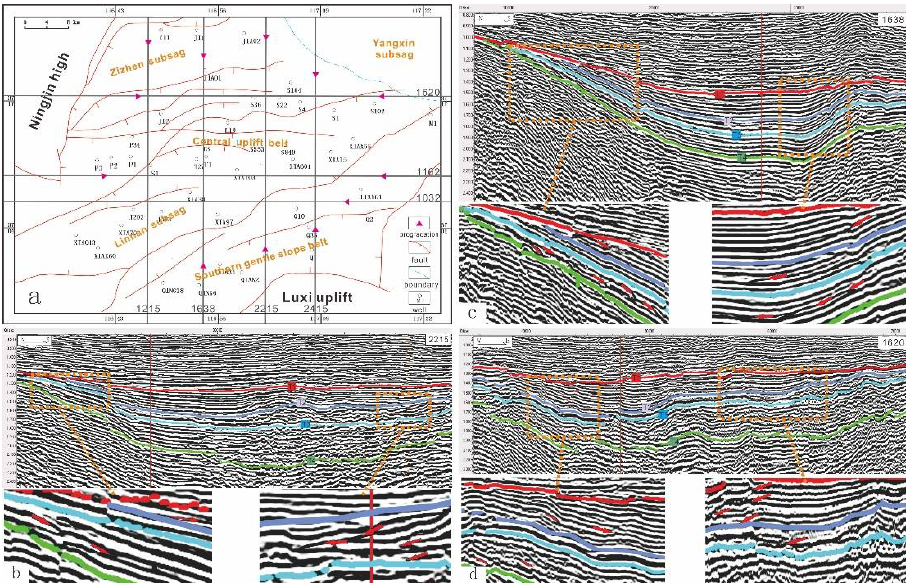
Figure 8. ( a ) Seismic survey lines in the Huimin depression and the planar position of the main progradation reflection points of each survey line. The diagrams show the ( b ) progradation reflection characteristics of the Es 2 to the Ed in north–south trending seismic section 2215, ( c ) progradation reflection characteristics of the Es 2 to the Ed in north–south trending seismic section 1638, and ( d ) the progradation reflection characteristics of the Es 2 to the Ed in west–east trending seismic section 1620.